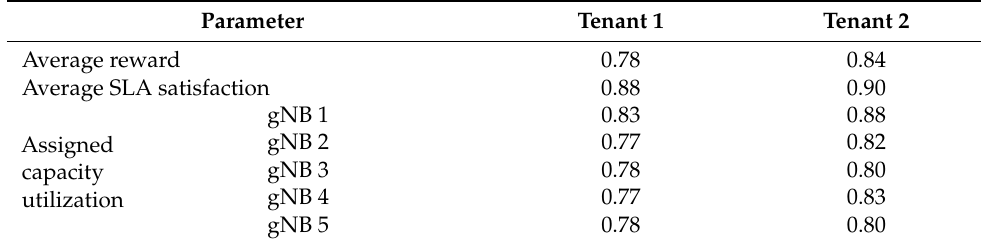
Table 4. KPI metrics obtained from KPI metrics model